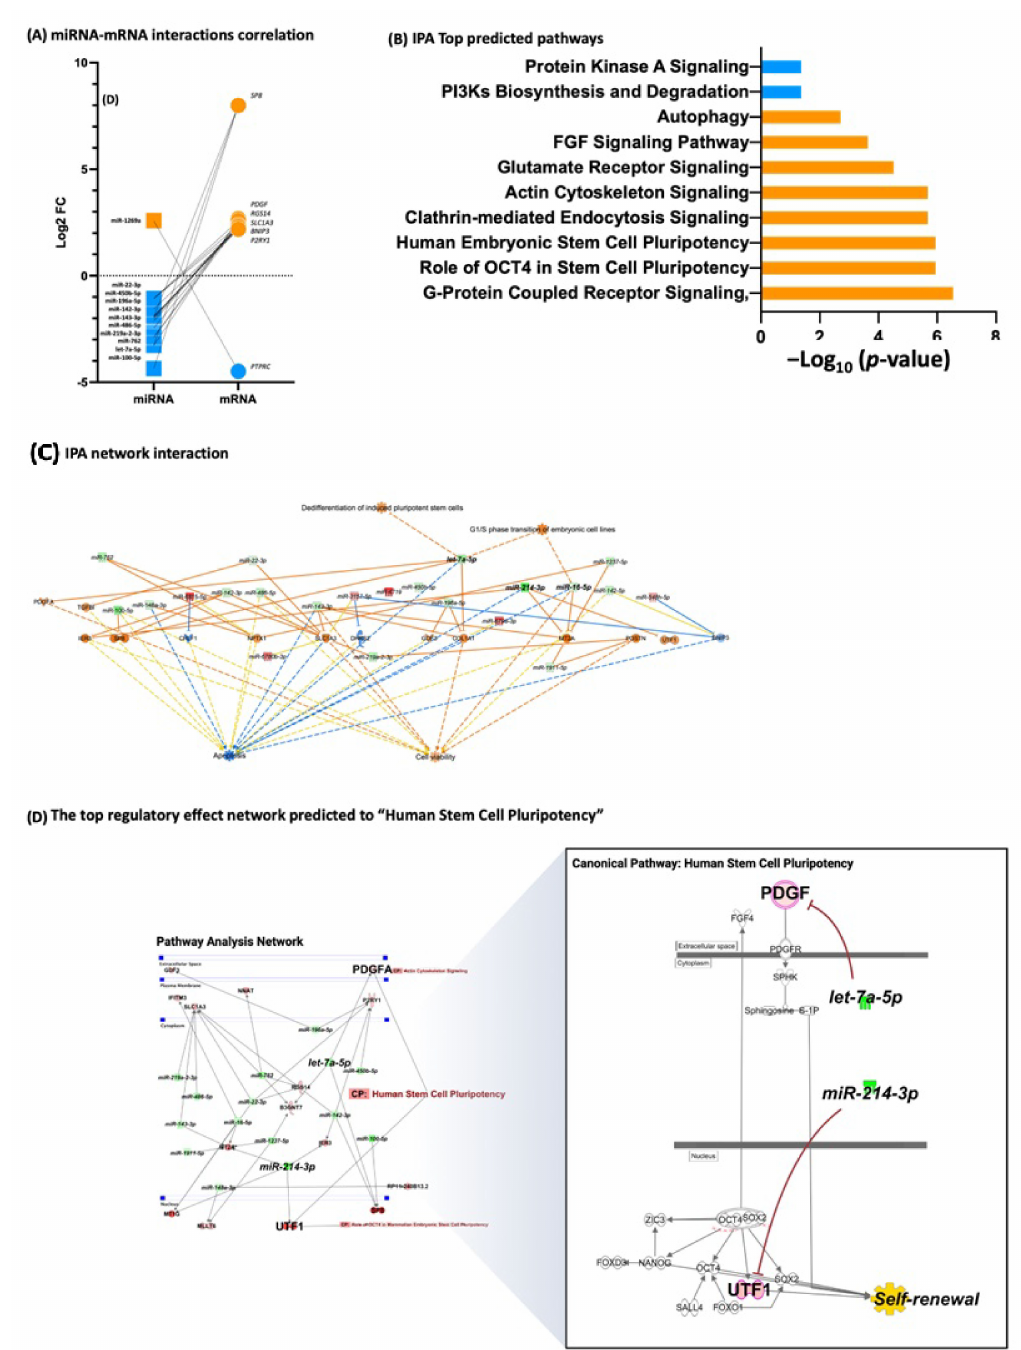
Figure 5. miRNA–mRNA interactions and predicted pathways in iPSCs with high reprogramming efficiency. ( A ) miRNA-mRNA interactions correlation. ( B ) A bar graph of the top predicted pathways; orange bars correspond to upregulated pathways and blue to the downregulated ones. ( C ) Predicted canonical pathways encoding stemness, cellular development, growth and proliferation, cellular assembly and organization, pluripotency, and self-renewal of human iPSCs. The genes shaded in orange or red are upregulated and those that are blue or green are downregulated. ( D ) Predicted canonical pathway encoding specifically “Human Stem Cell Pluripotency”. The genes shaded in red are upregulated and those that are green are downregulated. The intensity of the shading shows to what degree each gene was up- or down-regulated. A solid line represents a direct interaction between the two gene products and a dotted line represents an indirect